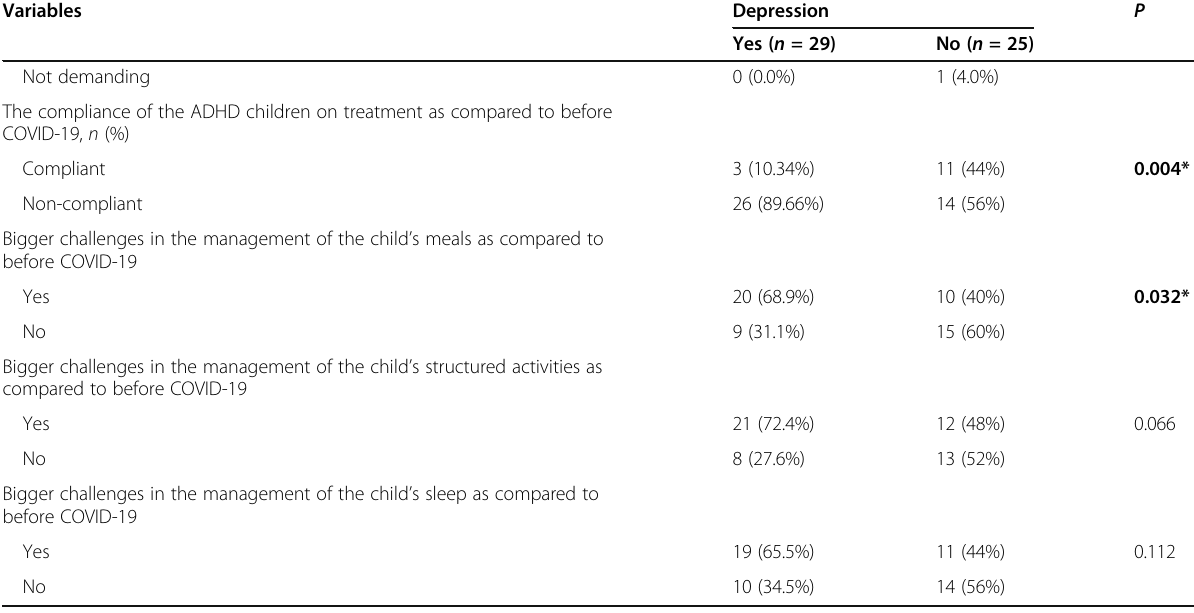
Table 3 Association between depression and other characteristics in mothers of ADHD children (Continued)